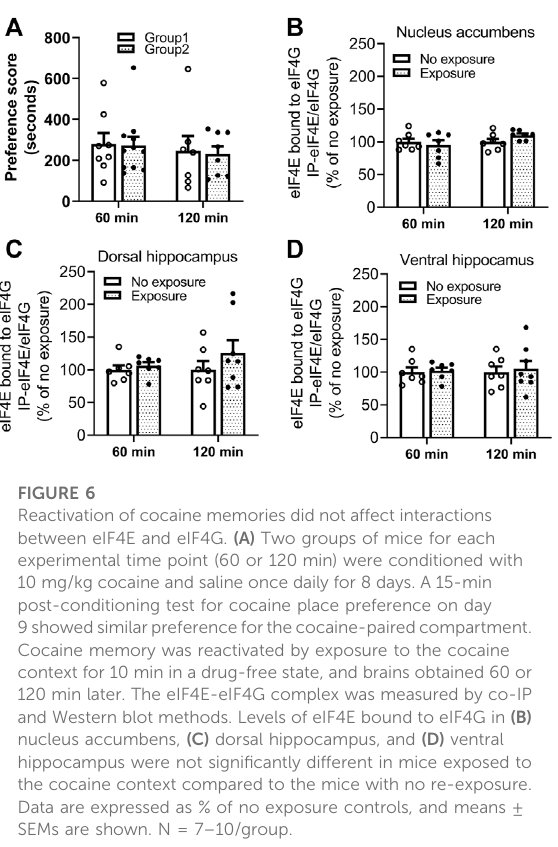
accumbens (B. 60 min: t = 0.5521, df = 12, p > 0.05; 120 min: t = 1.864, df = 12, p > 0.05), dorsal hippocampus (C. 60 min: t = 0.7580, df = 12, p > 0.05; 120 min: t = 1.055, df = 13, p > 0.05) and ventral hippocampus (D. 60 min: t = 0.2381, df = 12, p > 0.05;